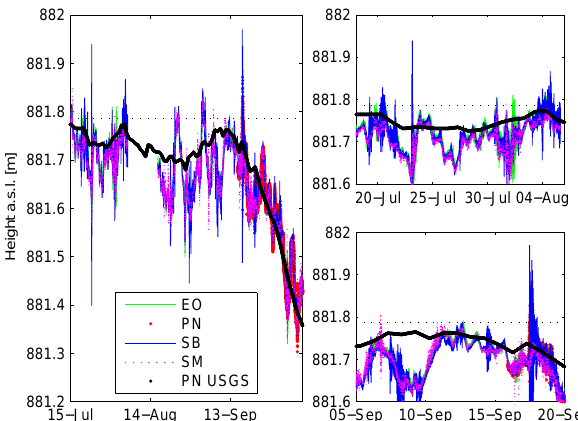
Figure 10. (a) A 3-month outtake of the lake surface oscillations in Flathead Lake. Panels (b) and (c) show a 15-day zoom of (a) for pe- riods of strong seiche oscillations. The thick solid line is the record from the USGS gauging station in Polson Bay used for regular lake level monitoring. Thin lines are derived from the pressure records at different positions in the lake (see Fig. 1 for measurement lo- cations). The dotted line marks the prescribed maximum regulated elevation of